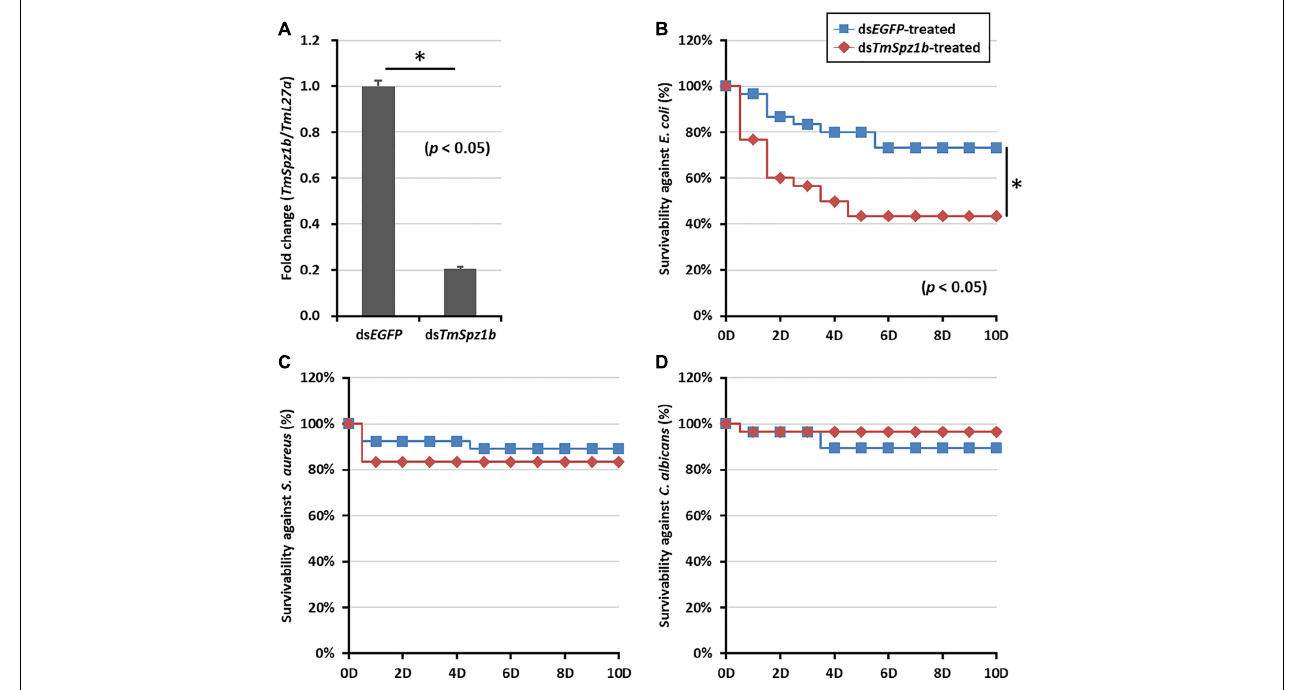
FIGURE 5 | Effects of TmSpz1b gene-silencing on larval survival upon microbial challenges. (A) Validation of RNAi in ds TmSpz1b treated larvae compared with that in dsEGFP-treated larvae. TmSpz1b expression was decreased by approximately 80% following the injection of TmSpz1b -specific dsRNAs, compared to that in the ds EGFP- treated group. E. coli (B) , S. aureus (C) , and C. albicans (D) were injected into TmSpz1b -silenced T. molitor larvae, and larval survival was monitored for 10 days. The ds EGFP- treated groups were used as controls. Survival of larvae infected with E. coli , but not S. aureus and C. albicans , was significantly decreased by TmSpz1b knockdown. The data are an average of three biologically independent replicate experiments. Asterisks indicate significant differences between ds TmSpz4- and ds EGFP- injected groups ( P < 0.05). Statistical analysis of survival analysis was carried out based on Kaplan–Meier plots (log-rank chi-square test; ∗ P <